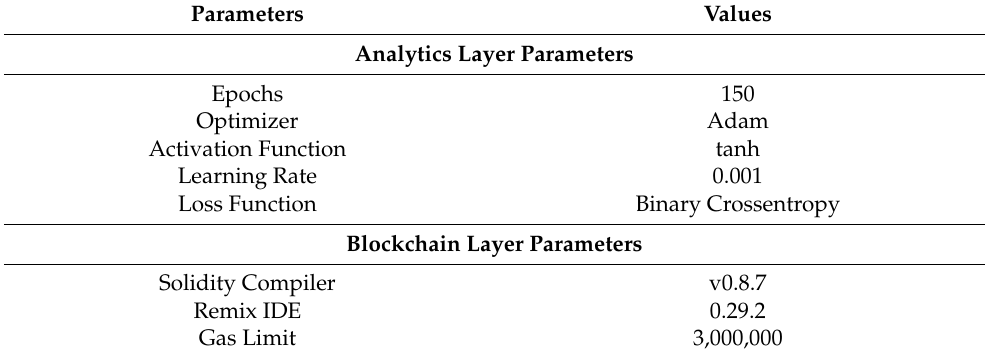
Table 3. Simulation parameters for the proposed HEART